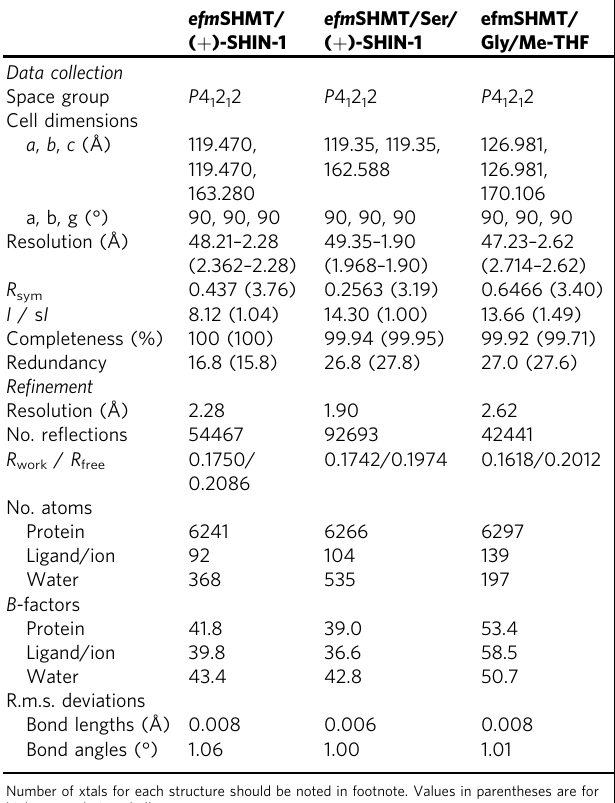
Table 3 Data collection and re fi nement statistics (molecular